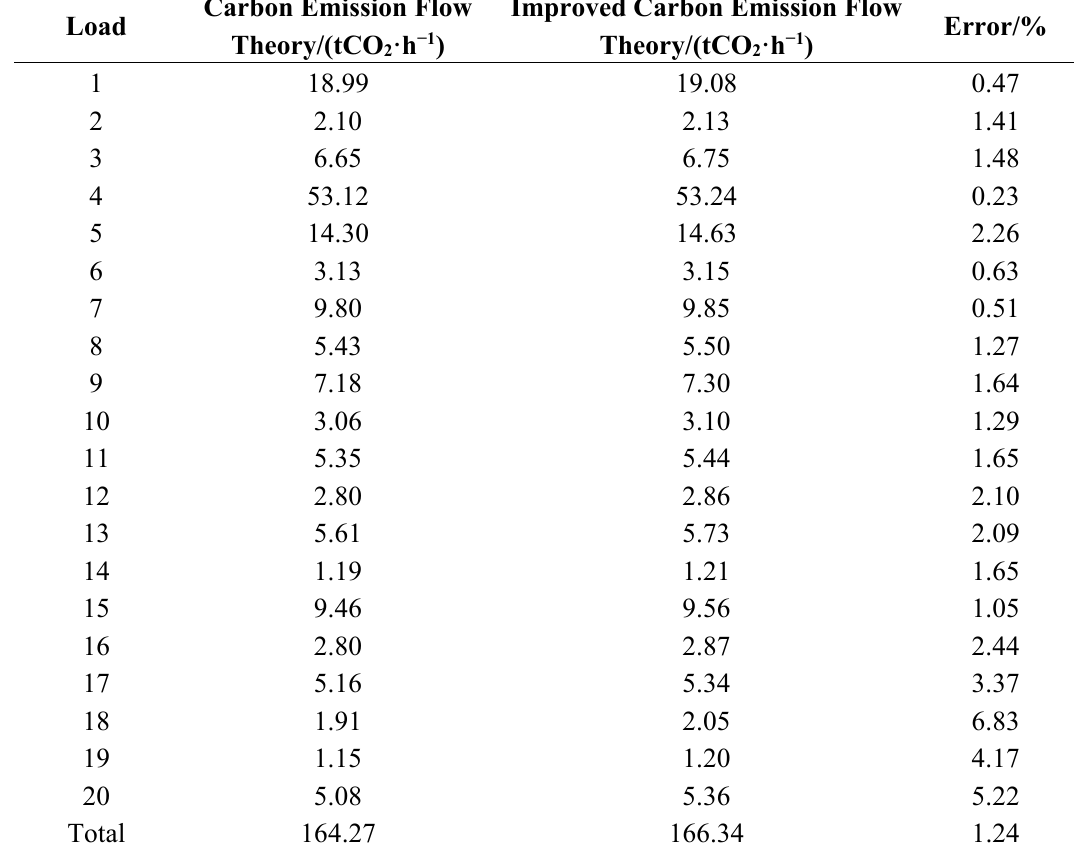
Figure 3. The contribution of each load to the carbon emission flow rate. Table 2. The emission carbon flow rates calculated by the carbon emission flow theory and the improved carbon emission flow